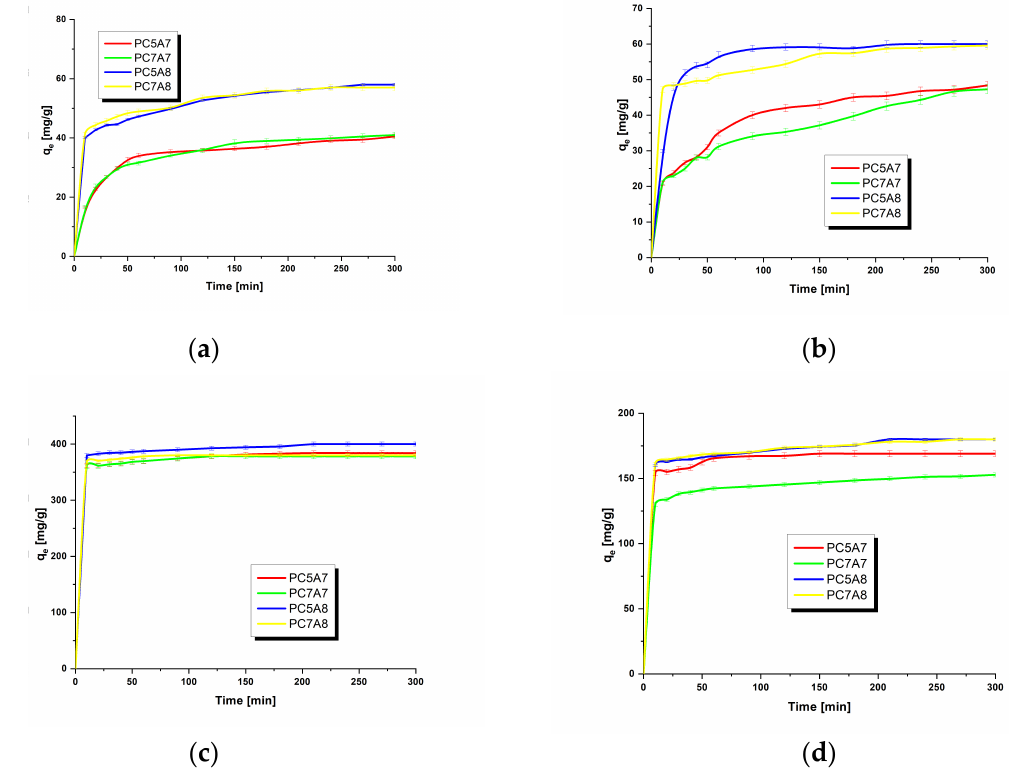
Figure 5. The effect of contact time on the amount of organic dyes adsorbed on the activated carbons: adsorbent mass = 25 mg, volume of solution = 50 mL, temperature =22 ± 2 °C, ( a ) methyl red 30 mg/L, ( b ) methylene blue 30 mg/L, ( c ) malachite green 200 mg/L and ( d ) crystal violet 90 mg/L).